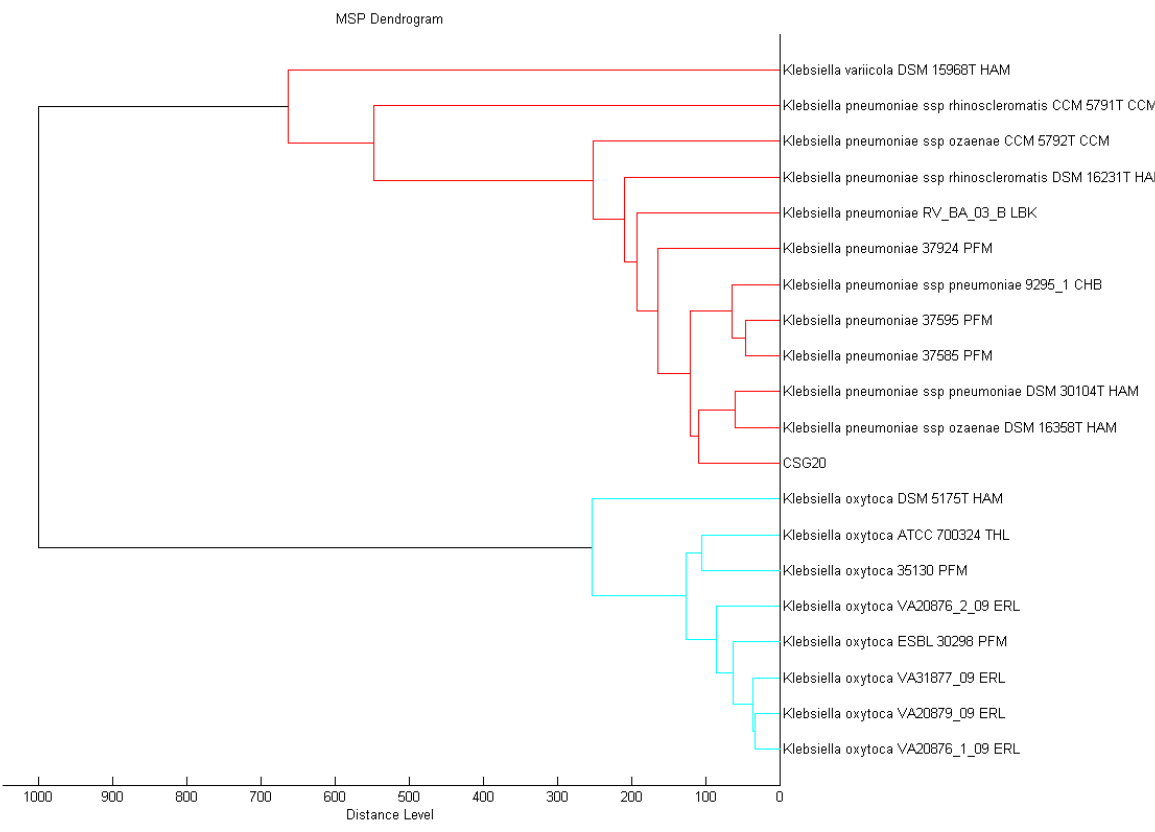
Figure 1. Score-oriented dendrogram of clinical isolate K. pneumoniae strain CSG2.